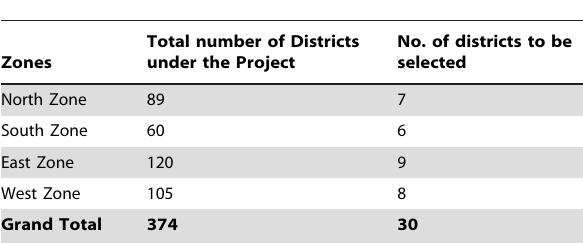
Table 1. Total number of districts selected zone wise from the Global Fund Round 9 Project districts for the cross- sectional community based survey, India,